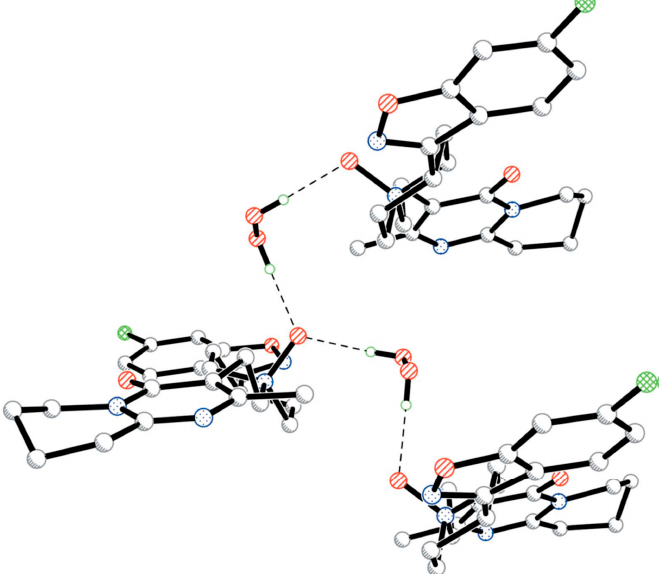
Figure 14. Fragment of the crystal structure of risperidone N-oxide, illustrating the interaction of hydrogen peroxide with coformer molecules through O-H···O bonds (dashed lines). H atoms attached to C atoms have been omitted for clarity. Reproduced with permission from the authors of [86]. Copyright 2005 International Union of Crystallography.